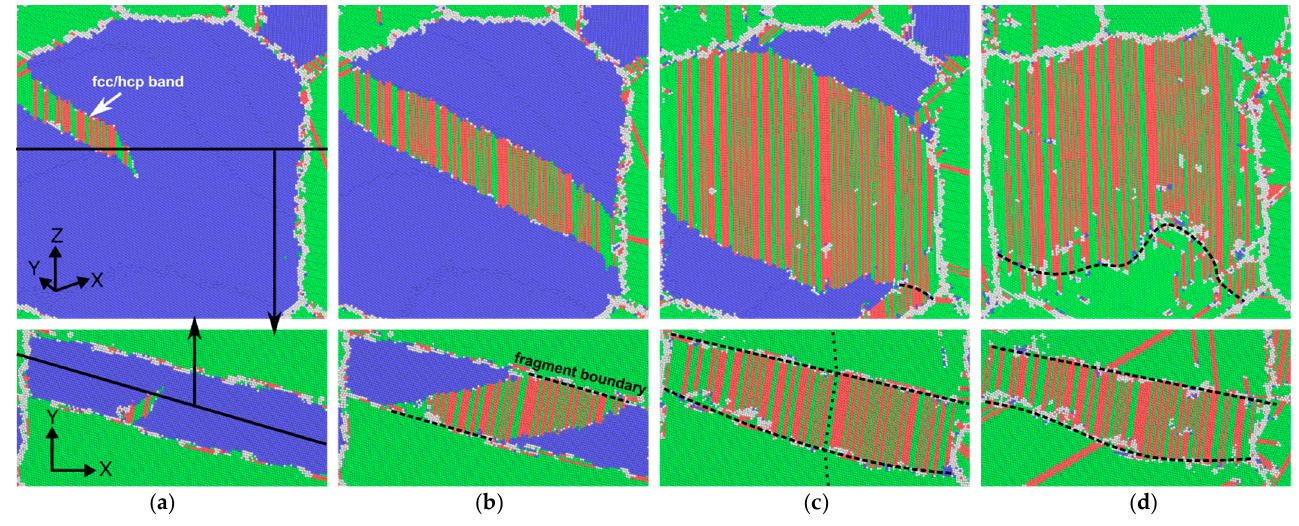
Figure 3. Cross-sections of a bcc lamella by the ( 1(cid:3364) 10) plane parallel to the bcc/fcc interface (upper row) and by the XY plane (lower row) at the strains 3.25 ( a ), 3.50 ( b ), 5.50 ( c ), and 15.25% ( d ). Atoms with bcc, fcc, hcp and uncertain nearest neighbor symmetry are highlighted in blue, green, red, and light grey, respectively. Traces of the sectional planes are marked off by the black solid lines. Grain reorientation is shown as a dotted line and fragment boundaries as dashed lines.